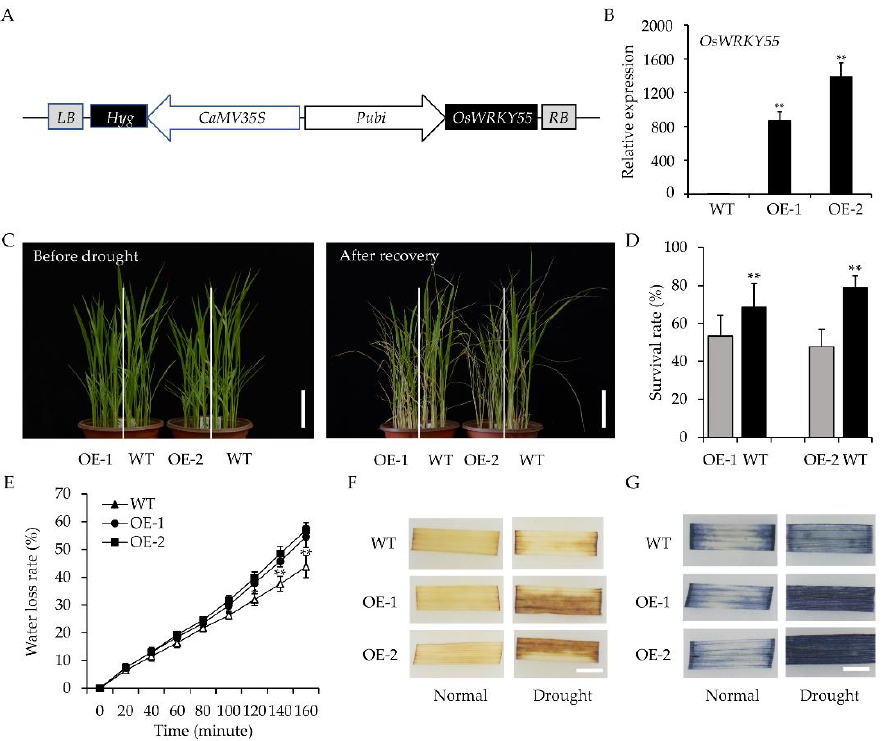
Figure 1. Overexpression of OsWRKY55 increases the sensitivity of rice seedlings to drought stress. ( A ) Diagrams of the overexpression plasmid of OsWRKY55 . ( B ) The OsWRKY55 mRNA level in each genotype was analyzed by quantitative reverse transcription PCR (qRT-PCR). The rice OsActin gene was used as the internal control. ( C ) Appearance of wild-type (WT) and transgenic seedlings (OE-1 and OE-2) before drought stress and after 7 days of recovery (rewatering). Scale bars = 5 cm. ( D ) Survival rates of WT and transgenic seedlings after recovery for 7 days. ( E ) Water loss assay of WT, OE-1, and OE-2. ( F ) 3, 3′ -diaminobenzidine (DAB) staining showing the level of hydrogen peroxide (H 2 O 2 ) in the leaves of WT and transgenic plants under normal and drought-stress conditions. Scale bars = 0.5 cm. ( G ) Nitro-blue tetrazolium (NBT) staining showing the level of superoxide radical (O 2 − · ) in the leaves of WT and transgenic plants under normal and drought-stress conditions. Scale bars = 0.5 cm. In all graphs, values shown are means ± SD (n = 3), * p < 0.05, ** p < 0.01 (Student ’ s t -test).